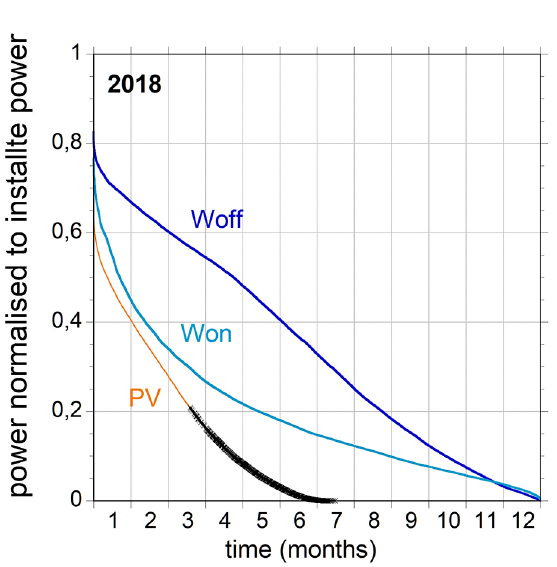
Fig. 10. – Annual duration curves for 2018 are shown for the three cases identified in fig. 9. The black PV symbols denote January and December values. Data from ENTSO-E and the German grid